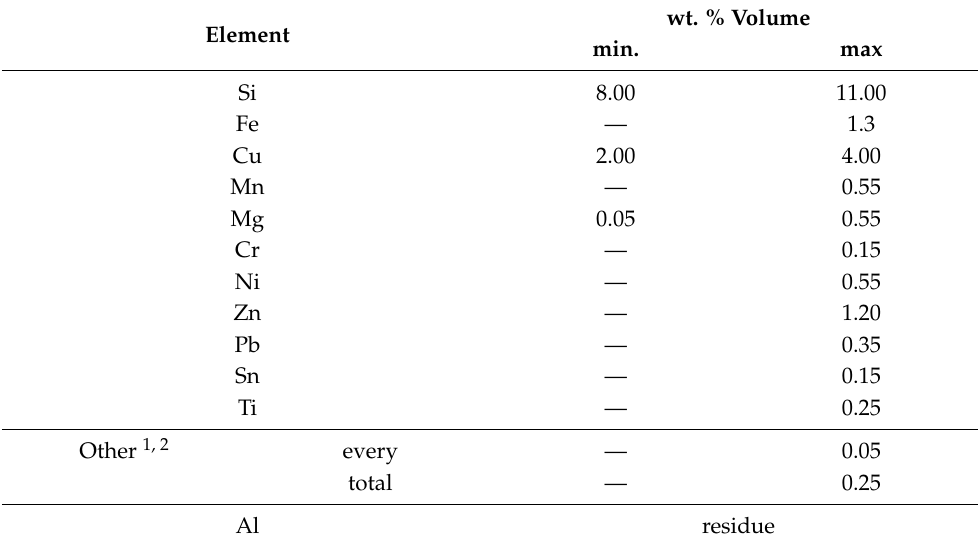
Table 1. Prescribed chemical composition of EN AC-46000 alloy in accordance with standard EN1706. Element